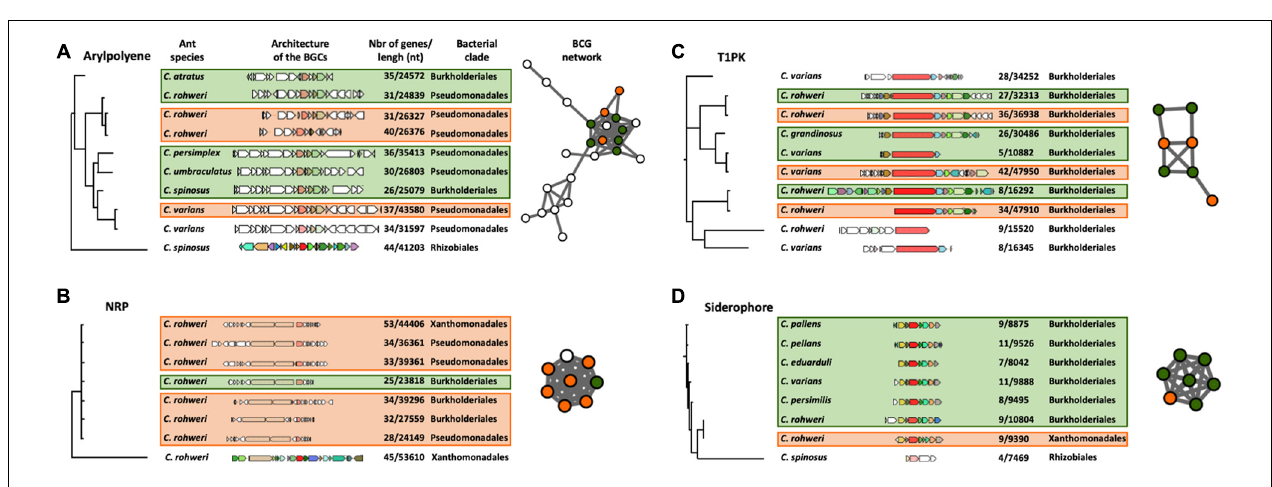
applications has become a growing field (Ziemert et